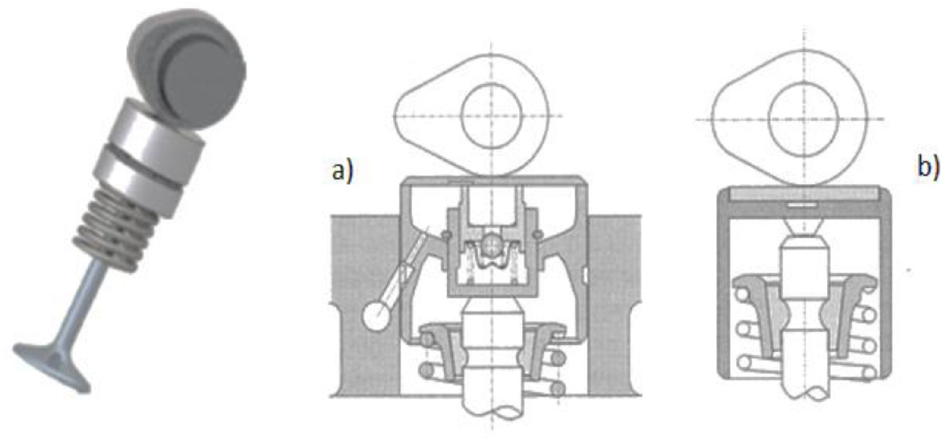
Figure 1. Valvetrain system with direct drive: ( a ) hydraulic tappet; ( b ) mechanic tappet [20].